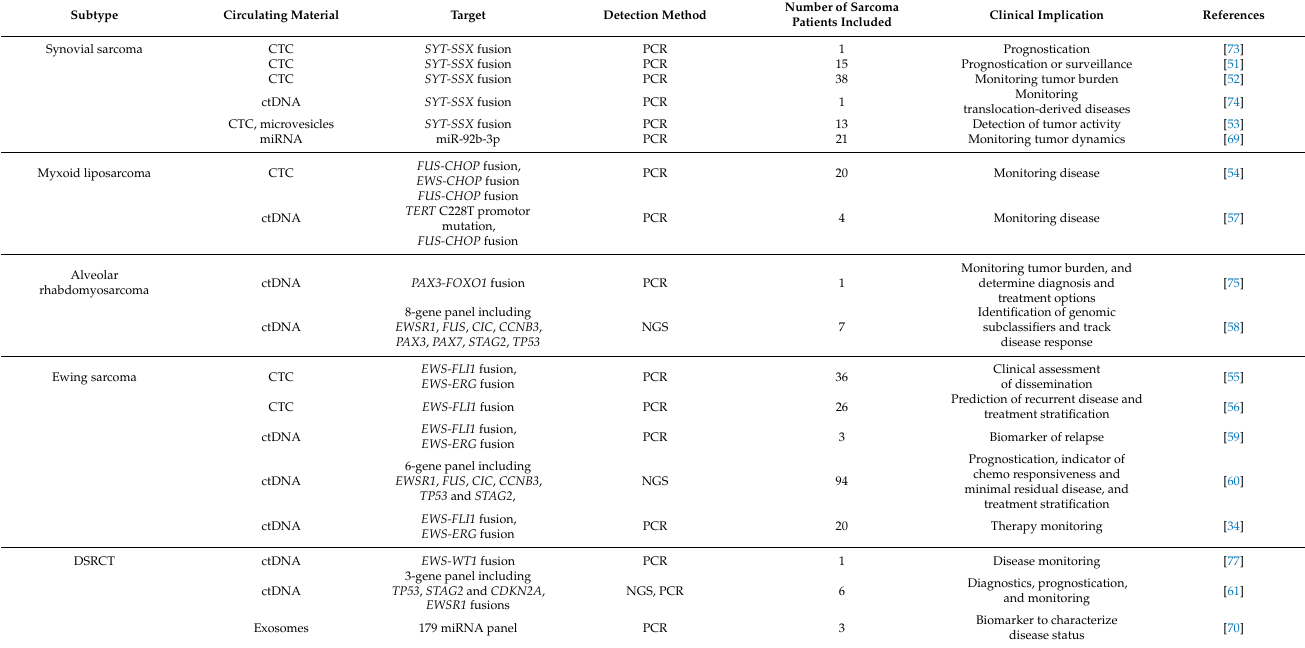
Table 3. Overview of studies of sarcoma liquid biopsy discussed in this review. DSRCT: desmoplastic small round cell tumor; GIST: gastrointestinal stromal tumor; LMS: leiomyosarcoma; MPNST: malignant peripheral nerve sheet tumor; STS: soft tissue sarcoma; SNV: single nucleotide variants; NGS: next generation sequencing; PCR: polymerase chain